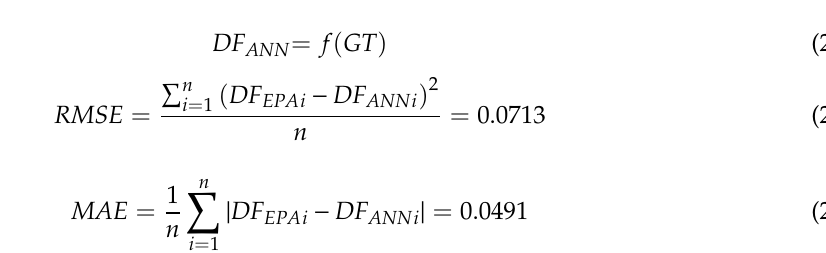
The error analysis of the estimated dilution factors based on the gross ton was made with